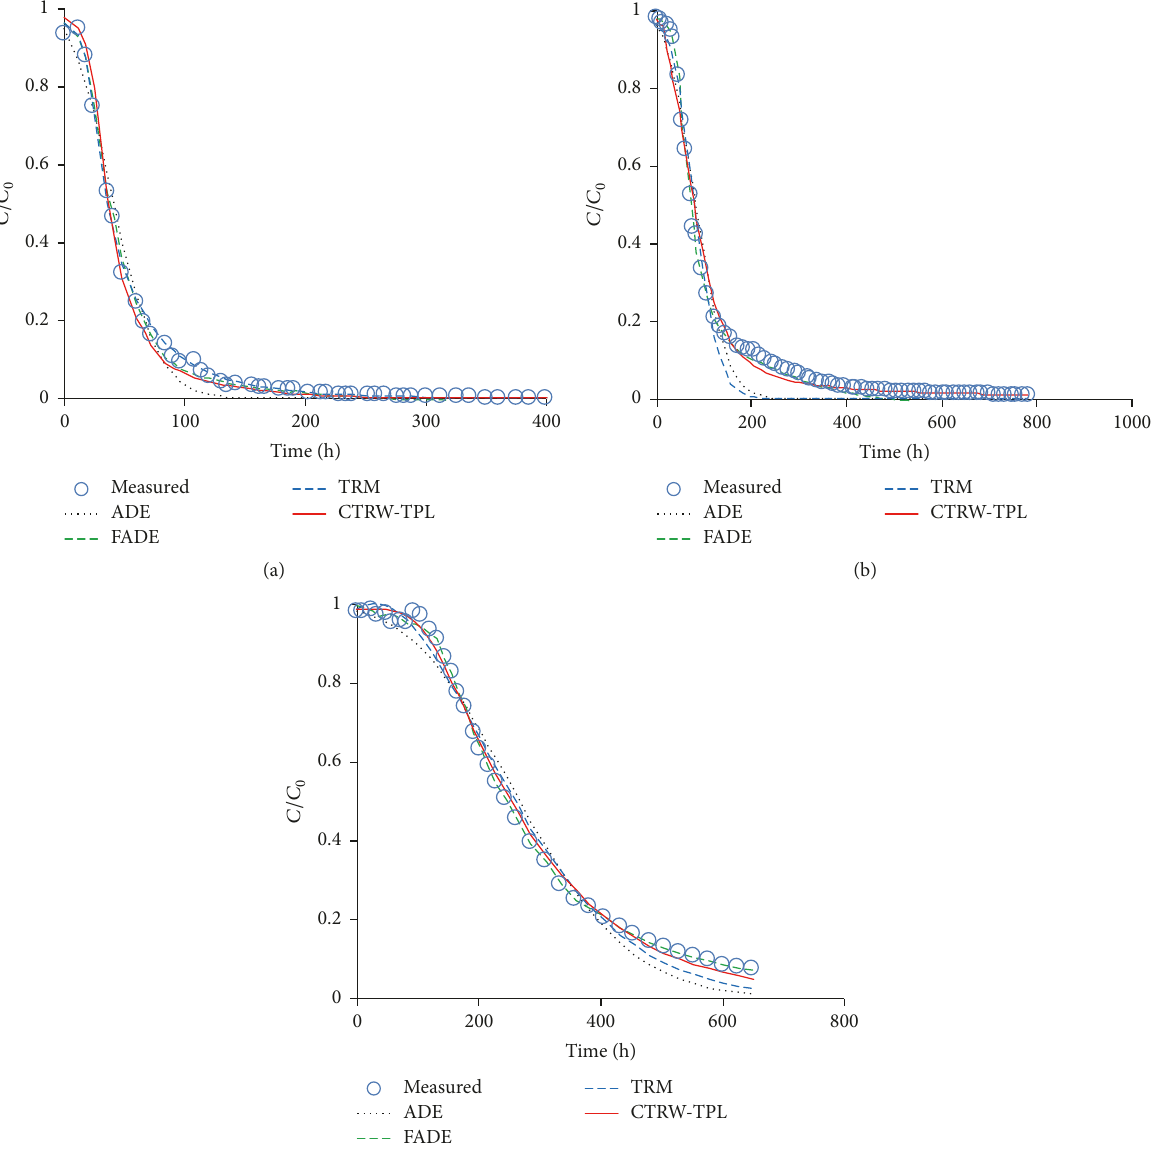
the same. This may qualitatively explain the slight increase of concentration (bump) observed in Figures 6(b) and 8(b).